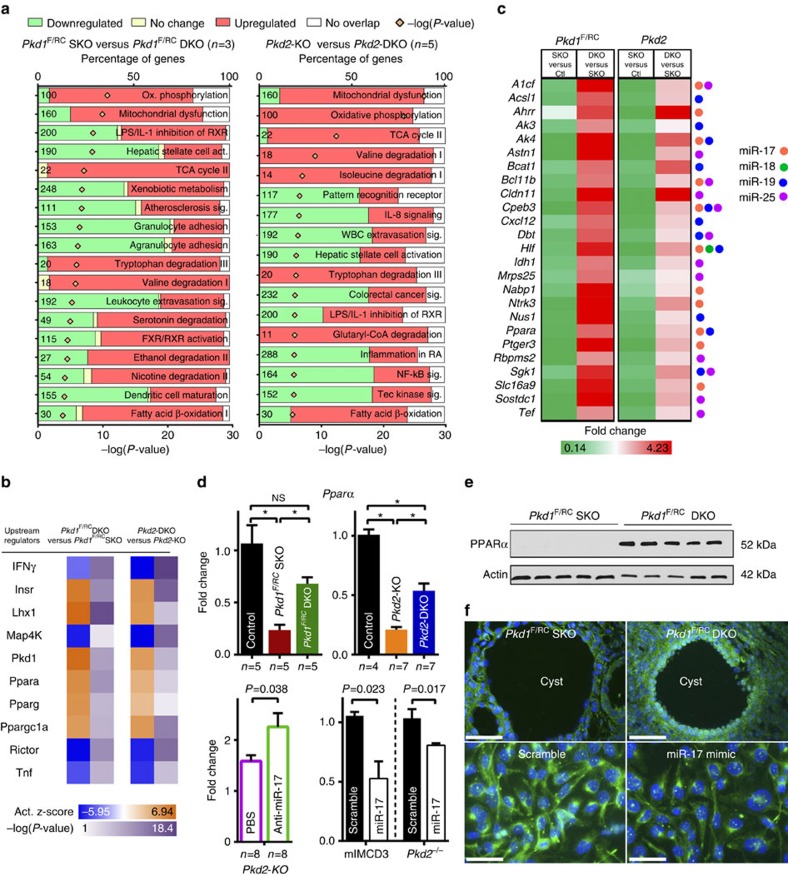
miR-17∼92 deletion results in improved expression of mitochondrial and metabolism-related gene networks.RNA-Seq analysis was performed to compare mRNA expression profiles. (a) Top differentially regulated pathways in 21-day-old Pkd1F/RCDKO compared with Pkd1F/RCSKO kidneys, and 21-day-old Pkd2-miR-17∼92KO compared with Pkd2-KO kidneys are shown. (b) Ingenuity pathway analysis software was used to identify the upstream regulators (URs) that may be responsible for the gene expression changes observed after miR-17∼92 deletion in ADPKD models. Top 10 (based on z scores) differentially expressed gene networks and their associated URs in Pkd1F/RCDKO compared with Pkd1F/RCSKO kidneys are shown. These networks were also differentially regulated in Pkd2-miR-17∼92KO compared with Pkd2-KO kidneys. Positive z scores (shades of orange) indicate activation whereas negative z scores (shades of blue) indicate inhibition of the gene networks. The P values (shades of purple) represent the level of statistical confidence for the prediction that the differentially expressed gene network is indeed regulated by the indicated UR. Large interconnected gene networks controlled by URs PPARα, PPARg and PPARGC1a were predicted to be activated after miR-17∼92 deletion in both ADPKD models. (c) RNA-Seq data were intersected with high-probability miR-17∼92 targets predicted by TargetScan. This analysis identified Pparα and 24 other common putative miR-17∼92 targets in the context of ADPKD. Expression of these genes was decreased (shades of green) in single knockout (SKO) compared with their respective control (Ctl) kidneys. In contrast, the expression of these genes was increased (shades of red) in double knockout (DKO) compared with their respective SKO kidneys. SKO indicates either Pkd1F/RCSKO or Pkd2-KO, whereas DKO indicates either Pkd1F/RCDKO or Pkd2-miR-17∼92KO kidneys. The circles indicate predicted binding sites for the various miRNA families derived from the miR-17∼92 cluster. (d) Q-PCR analysis showing Pparα expression in the indicated mouse models or cell lines. (e) Western blot showing increased PPARα expression in Pkd1F/RCDKO compared with Pkd1F/RCSKO kidneys. (f) PPARα antibody staining revealed that PPARα expression was increased in cyst epithelia of Pkd1F/RCDKO mice compared with Pkd1F/RCSKO mice. PPARα expression was decreased in mIMCD3 cells treated with miR-17 mimic compared with scramble mimic. Error bars indicate s.e.m. *indicates P<0.05, ns indicates P>0.05. One-way ANOVA, Tukey's multiple comparisons test, Student's unpaired t-test. Scale bars, 50 μm (f, top panel) and 20 μm (f, bottom panel).